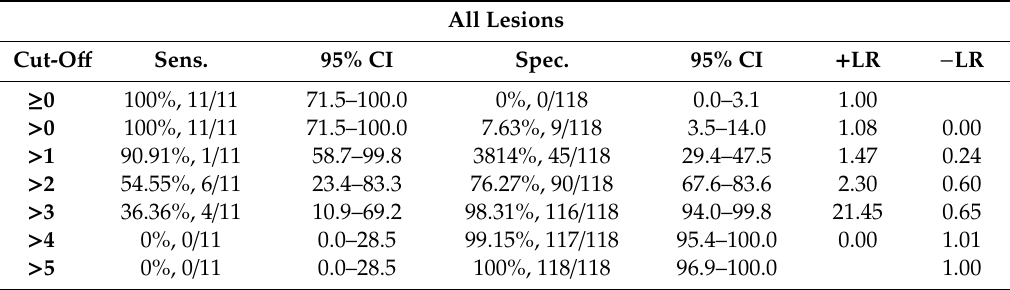
Table 3. Diagnostic parameters and cut-o ff values of the score for reader